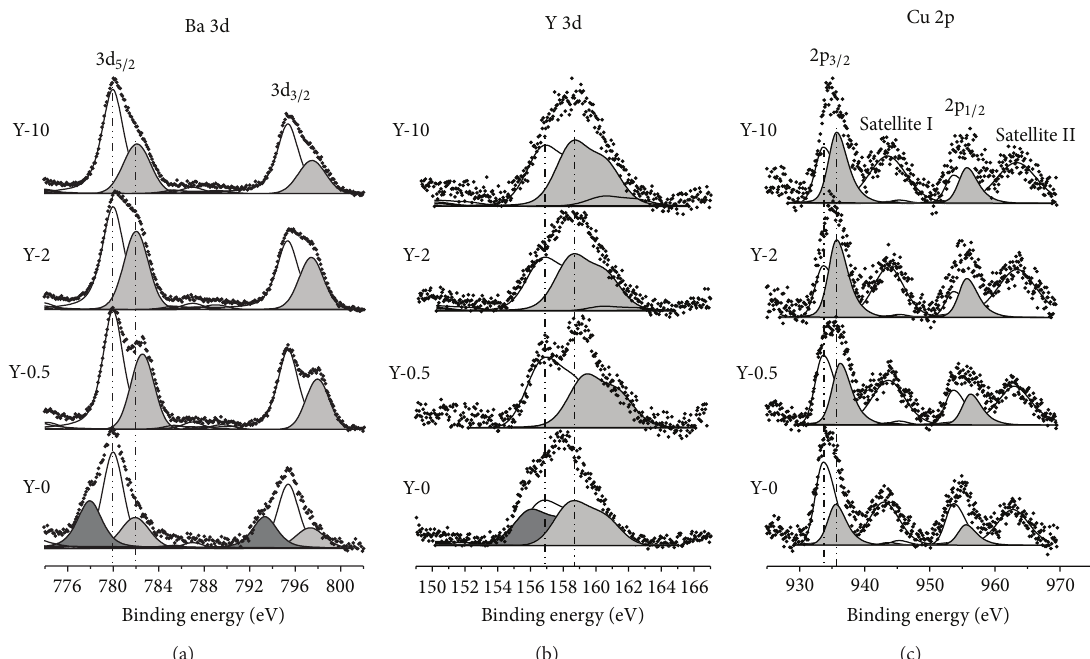
Figure 3: XPS spectra of YBa 2 Cu 3 O 6+𝛿 powders. Dark shading: the main phase signal; light shading: Y 2 BaCuO 5 signal.